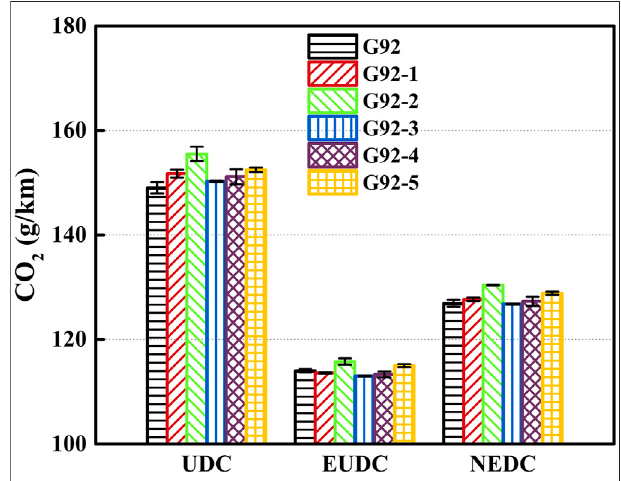
FIGURE 6 | The THC emissions of the vehicle fueled with different test fuels.